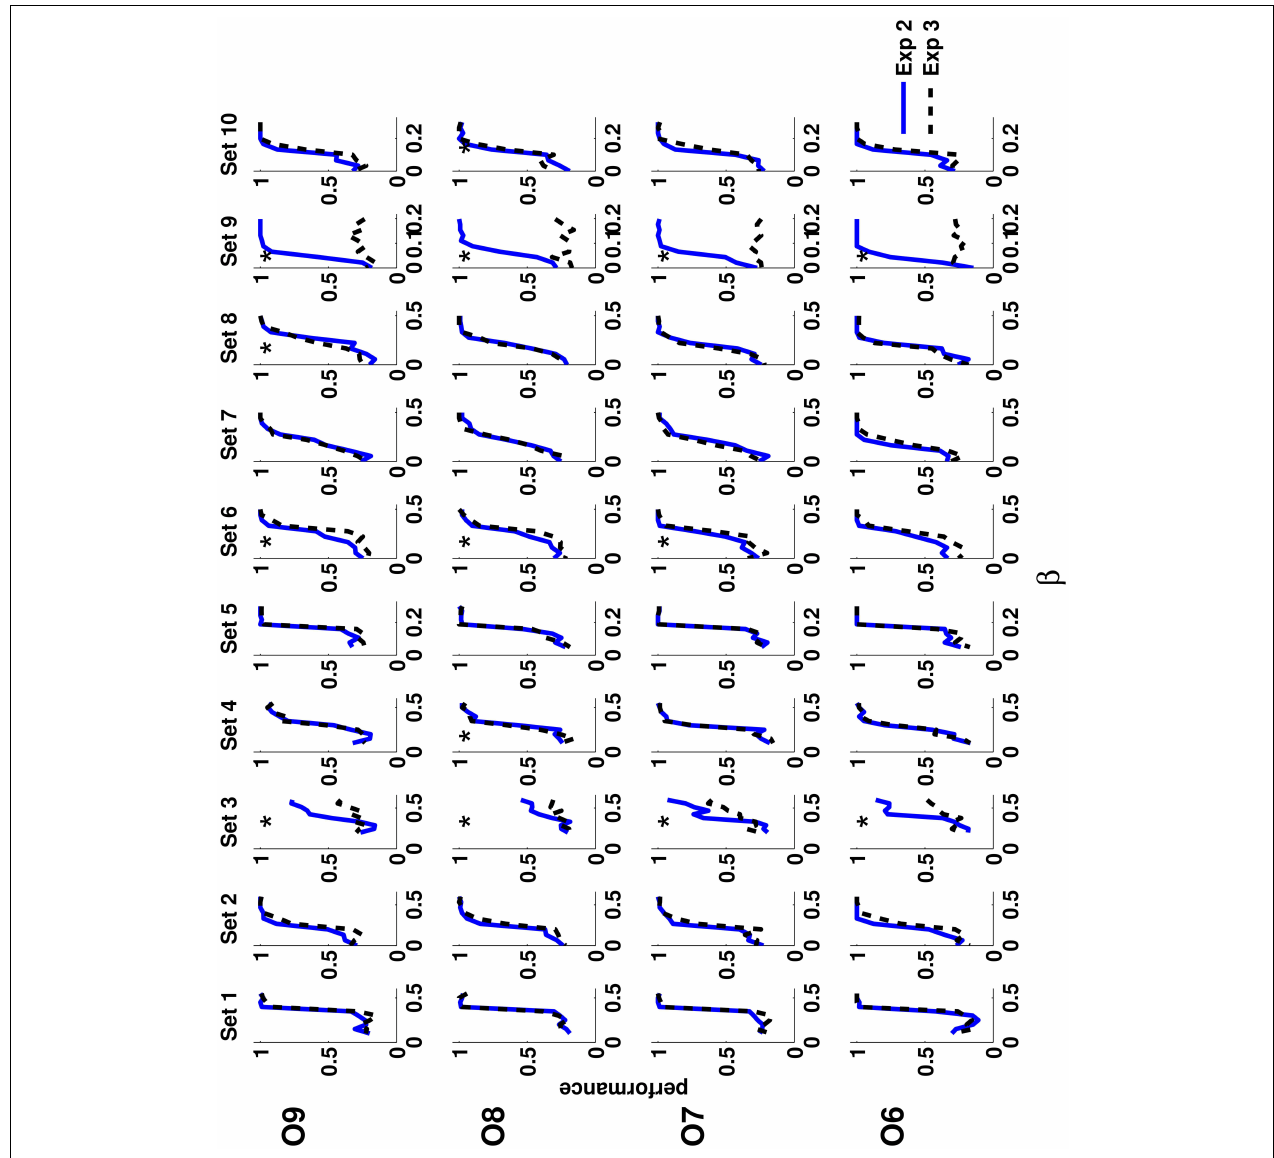
target and distracting quadrants in Experiment 3, whereas in Experiment 2 the amplitudes of Gaussian blobs in distracting quadrants were drawn from the uniform distribution of 3 values, and therefore, the luminance information could potentially be used in the task. A star denotes experimental conditions in which two curves are significantly different ( p val < 0 . 05 ) according to χ 2 statistical test (9 degrees of